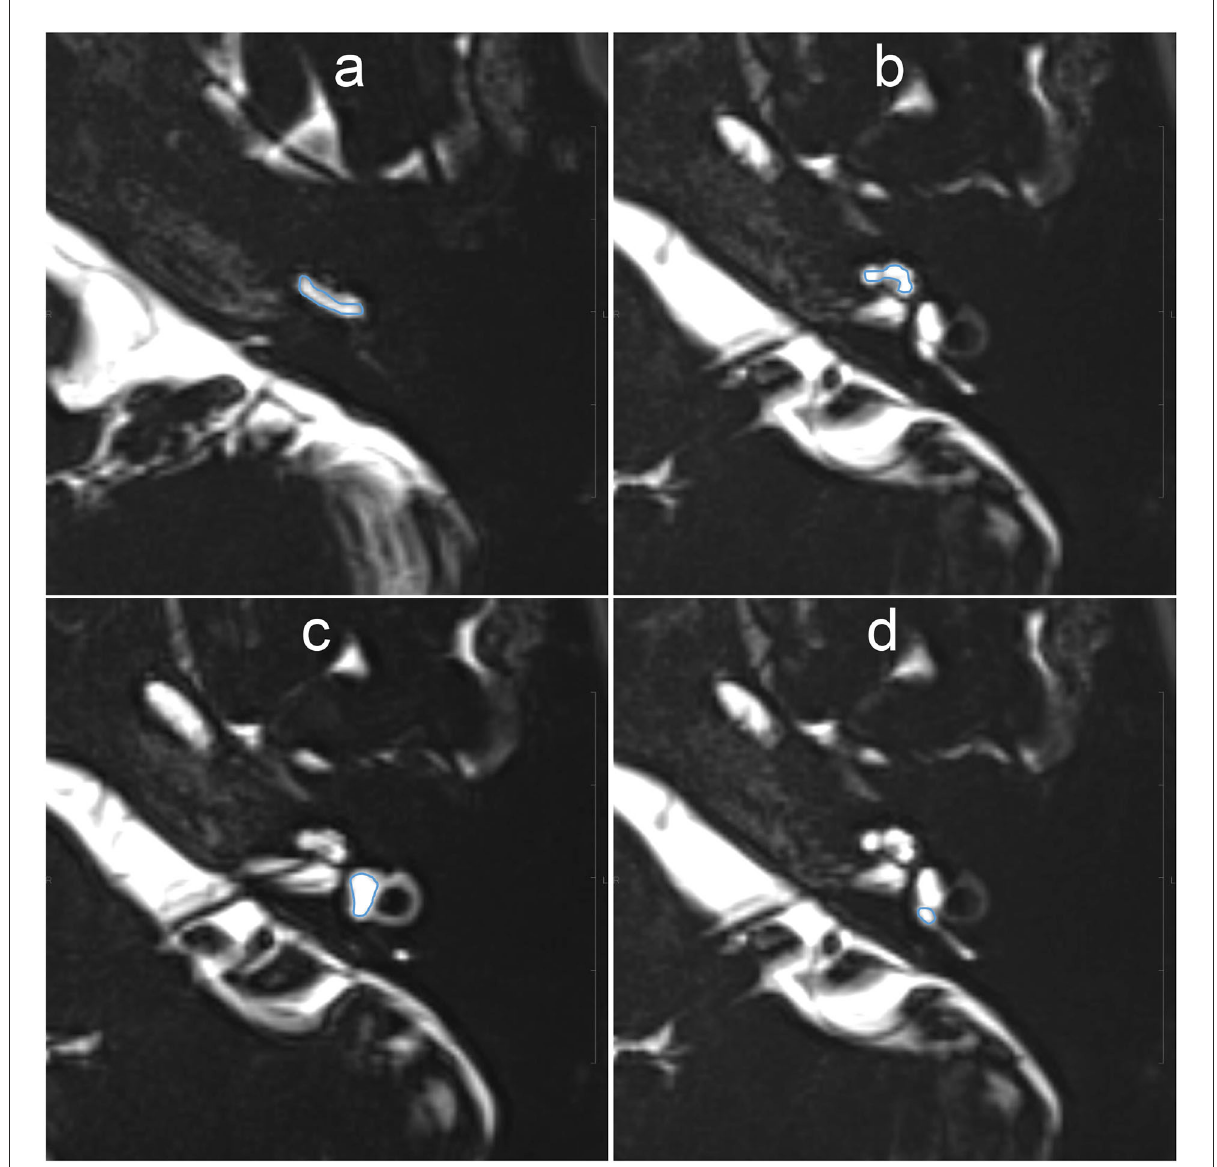
FIGURE3 Example images for setting of the region of interest (ROI) on MR images with an echo time (TE) of 540ms. The scala tympani of the basal turn of the cochlea (a) , whole apical–middle turn (b) , vestibule (c) , and the ampulla of the posterior semicircular canal (d) appeared contoured. The ROIs were then copied onto the other TE images. Each signal–intensity ratio was calculated using the signal value of the contralateral inner ear as a control.